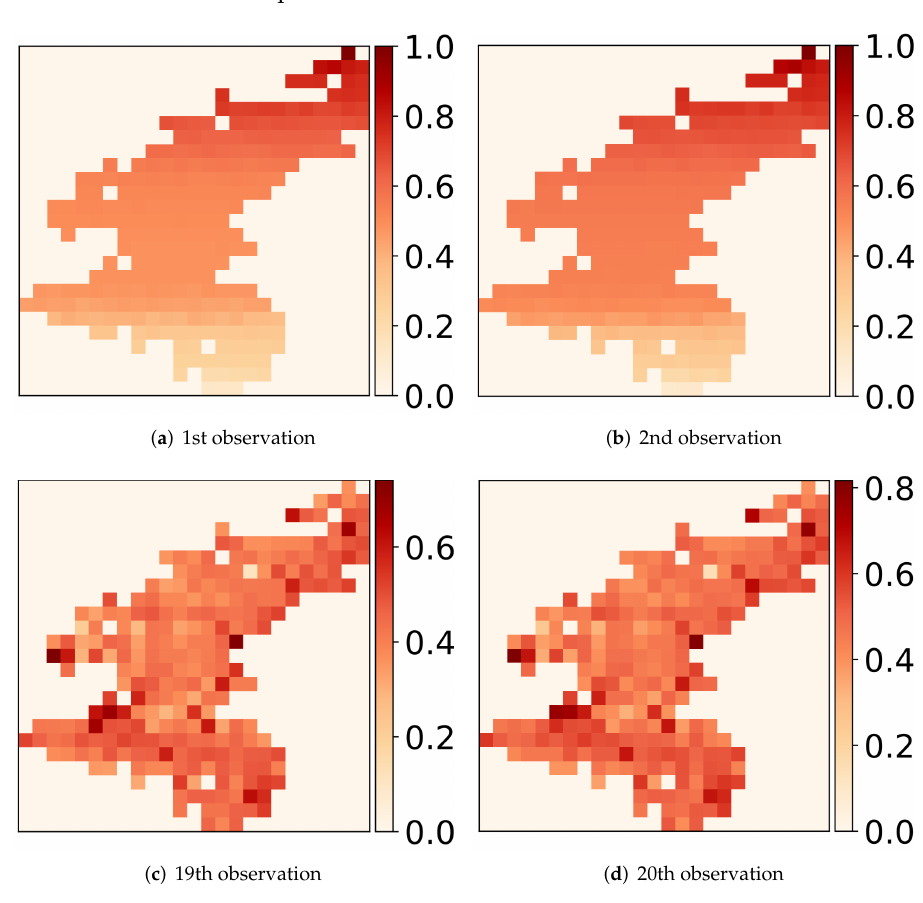
Figure 3. Heat map of displacements on 4 different days on west side.